Question: Briefly state, in one sentence, what is plotted here.
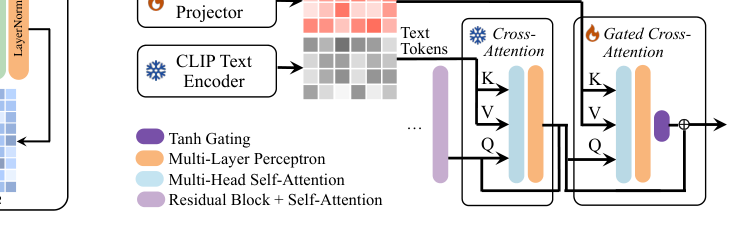
Answer: Gated cross-attention module. Our method guides the diffusion process by gated cross-attention and dense feed-forward layers added after pre-trained text-conditioned layers, using audio tokens as keys/values and ensuring training stability and quality.